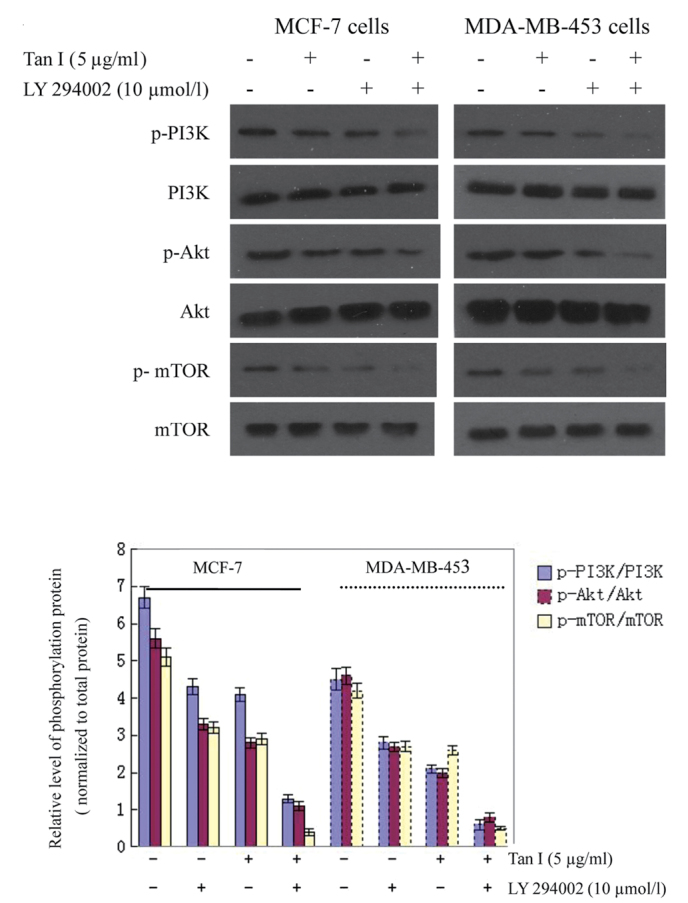
Inhibition of LY294002, following 48 h of treatment with Tan I, and the effect on the phosphorylation of PI3K, Akt and mTOR in breast cancer cells. Tan I, tanshinone I; PI3K, phosphatidylinositide 3-kinase; p-, phosphorylated; Akt, protein kinase B; mTOR, mammalian target of rapamycin.